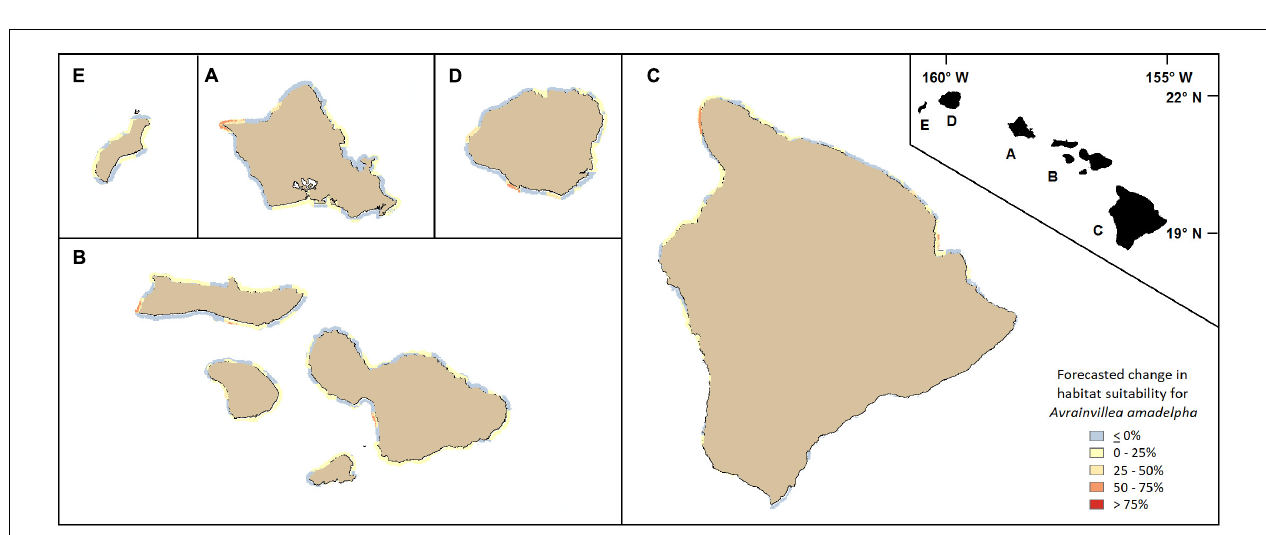
FIGURE 6 | Mapped model predictions around the MHI ( A: Oahu, B: Maui Nui, C: Hawaii, D: Kauai, E: Niihau) represented at 250 m raster resolution. Yellow or orange pixels indicate habitat less suitable for A. amadelpha invasion; red and purple pixels indicate regions identified as highly at risk for invasion.